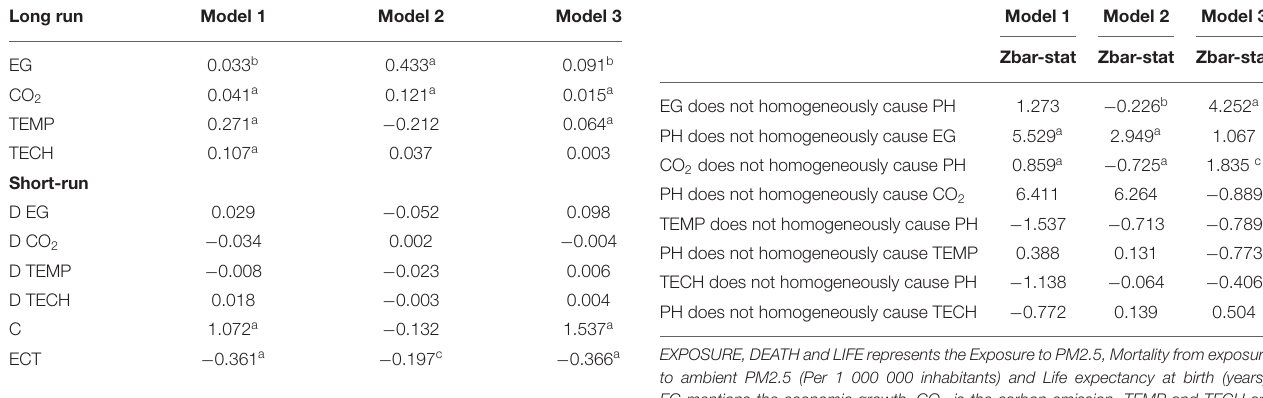
TABLE 7 | ARDL estimation. TABLE 8 | Pairwise Dumitrescu-Hurlin panel causality